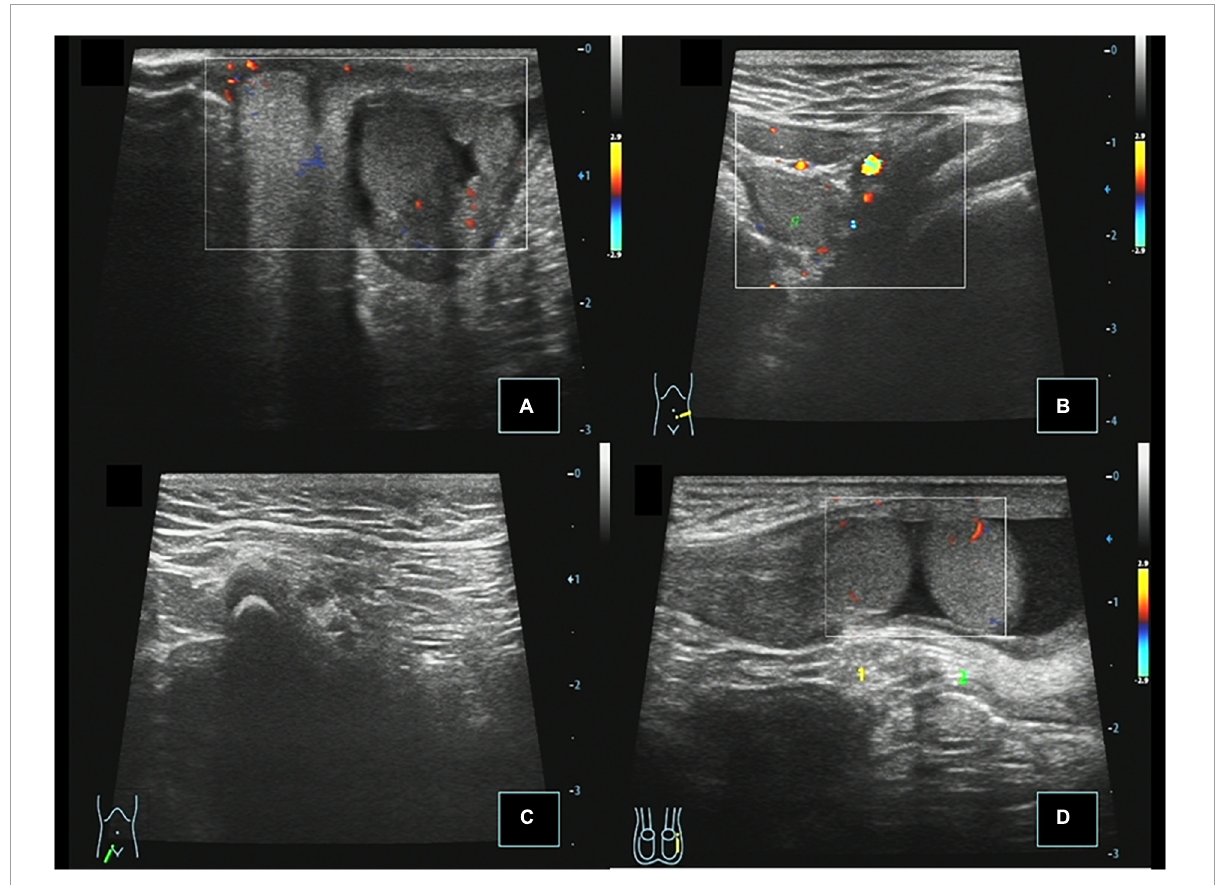
FIGURE2 Case 14, 0.67 years, chief complaint: right scrotal emptiness. Preoperative ultrasound: (A) Cross section of the scrotum showing that the left testis is located in the left scrotum, and there was no testis echo in the right scrotum. (B) Cross section of the left lower abdomen showing that the right testis is located next to the left iliac vessel, and CDFI showed punctate blood flow signals in the testis parenchyma. (C) Longitudinal view of the right inguinal region showing no spermatic cord echo. (D) When the child was crying, the right testis passed through the left inner ring to the left inguinal